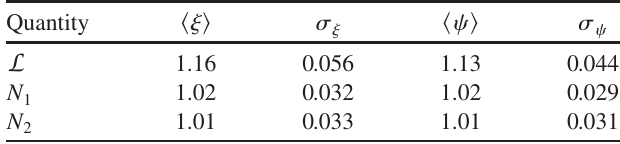
TABLE VII. The mean h (cid:14) i and the standard deviation (cid:9) (cid:14) of the ratio between simulated and measured quantity over 139 stores in run-7 without stochastic cooling in RHIC.